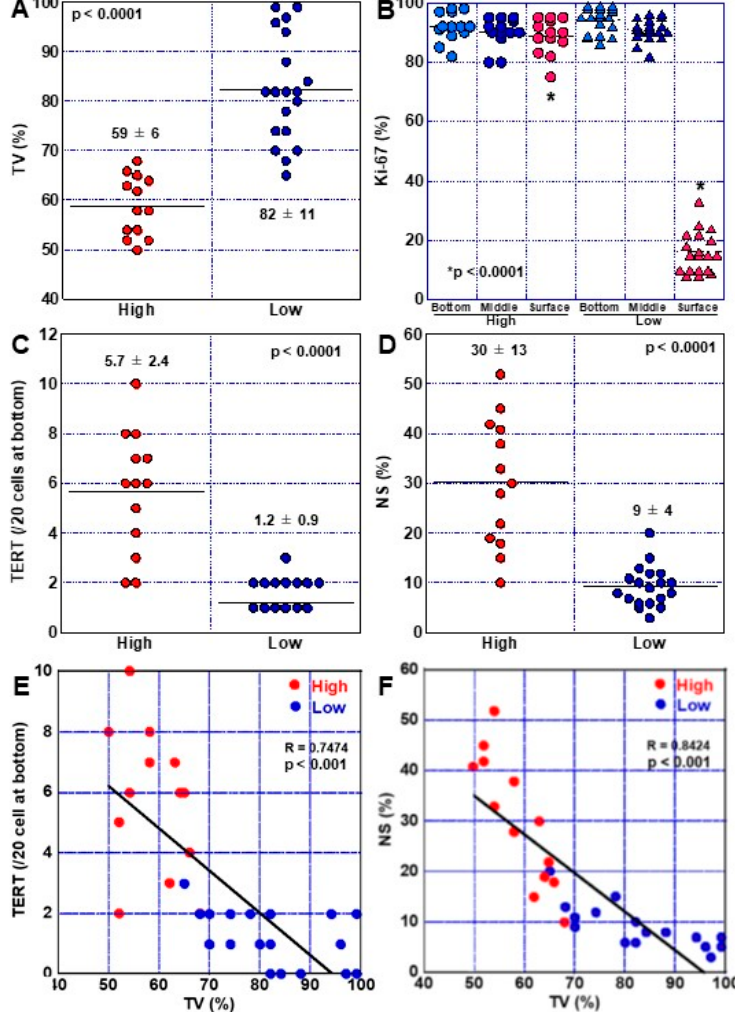
Figure 4. Comparison of high-grade and low-grade DM phenotypes. ( A – D ) TV ( A ), proliferation ( B ), TERT expression ( C ), and stemness ( D ) were compared between high-grade and low-grade DMs. ( E ) Relationship between TV and TERT expression. ( F ) Relationship between TV and stem cells. Data in panels, mean ± SD. DM, dysplastic metaplasia; High, high-grade DM; Low, low-grade DM; TV, telomere volume; TERT, telomerase reverse transcriptase; NS, nucleostemin; R, Pearson correlation coefficient.